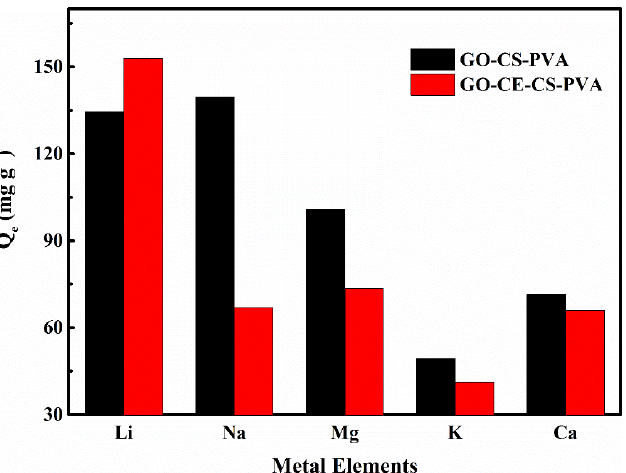
Figure 10. The selective adsorption diagram of GO–CE–CS–PVA and GO–CS–PVA for Li + and other ions. Table 4. The selective adsorption parameters of GO − CE − CS − PVA and GO − CS − PVA for Li + and other ions. GO-CS-PVA Metal Ions